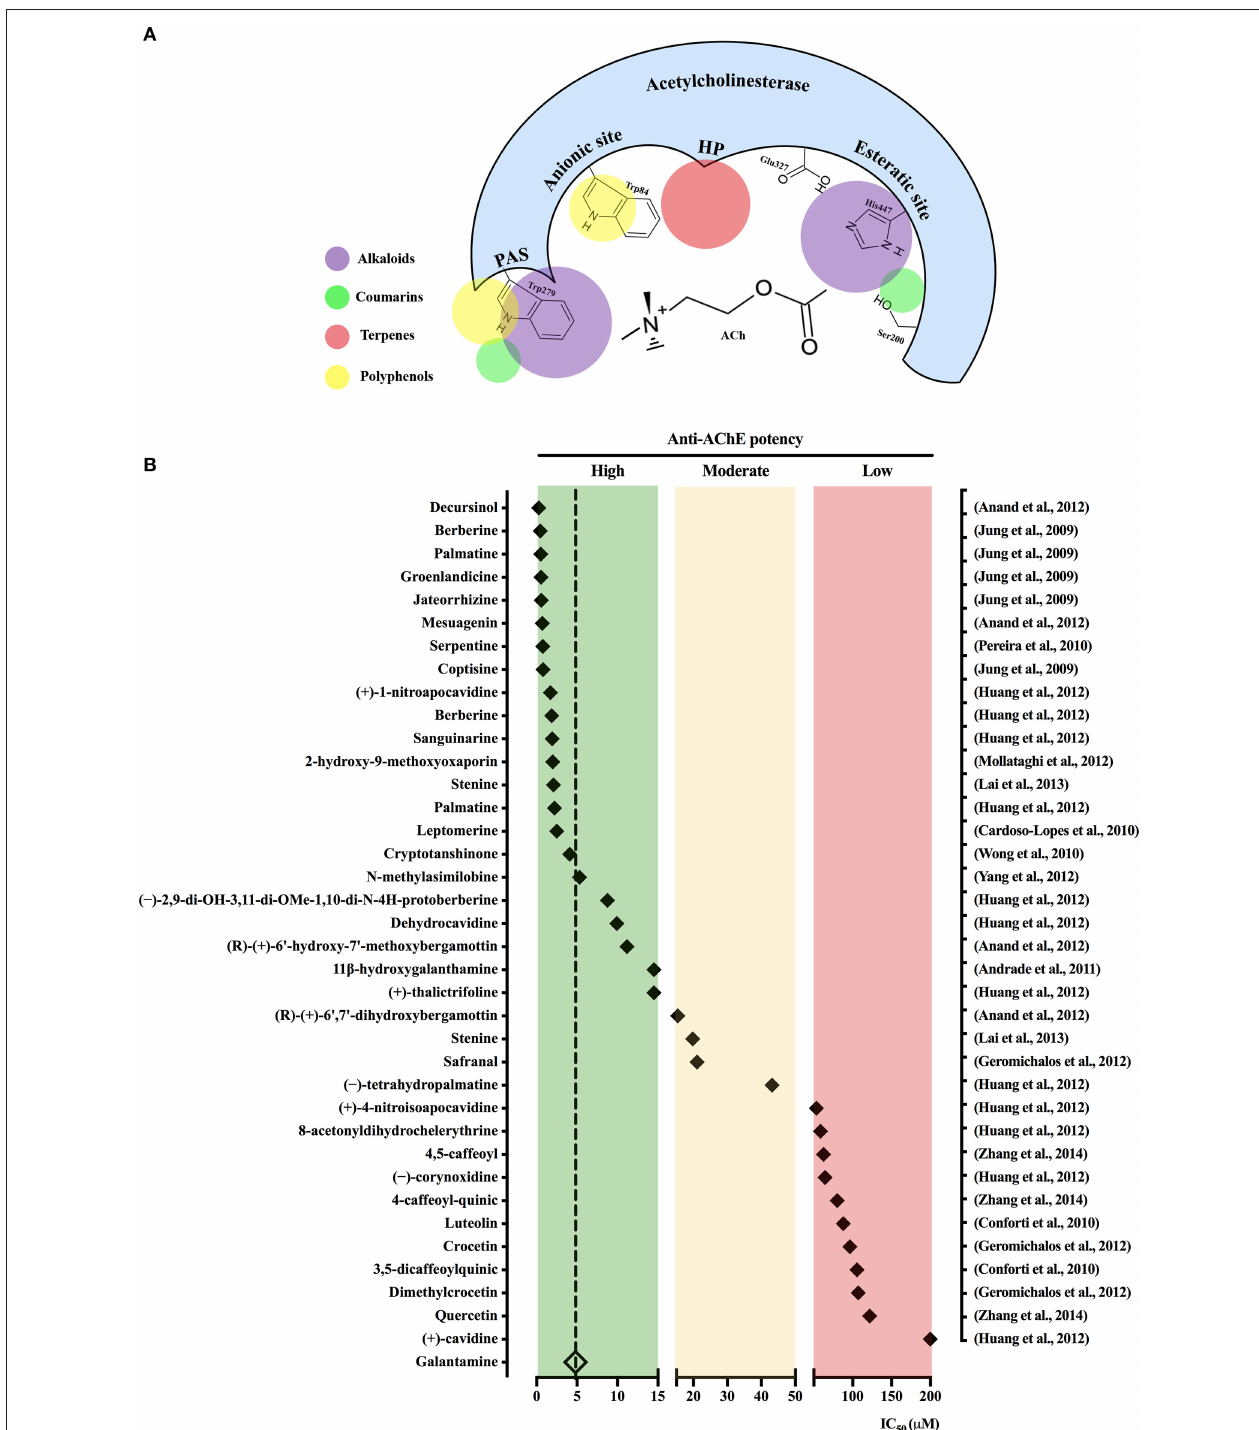
FIGURE 1 | Schematic view of acetylcholinesterase active binding sites for the main natural acetylcholinesterase inhibitors (AChEi) classes. (A) Acetylcholinesterase gorge pocket composed by the following binding sites: esteratic site, anionic site, peripheral anionic site (PAS), as well as hydrophobic pocket (HP) is shown. Colored circles represent the main binding sites for compounds pertaining to the indicated classes. (B) Natural AChEi reported in Pubmed from 2007 to 2018 (1st semester) were classified in accordance with the criteria described at Section Natural AChEi Compounds in: high potency (green background), moderate potency (orange background), and low potency (red background). The diamond symbol represents the IC 50 value for each compound (in the left) as described in the respective study (in the right).